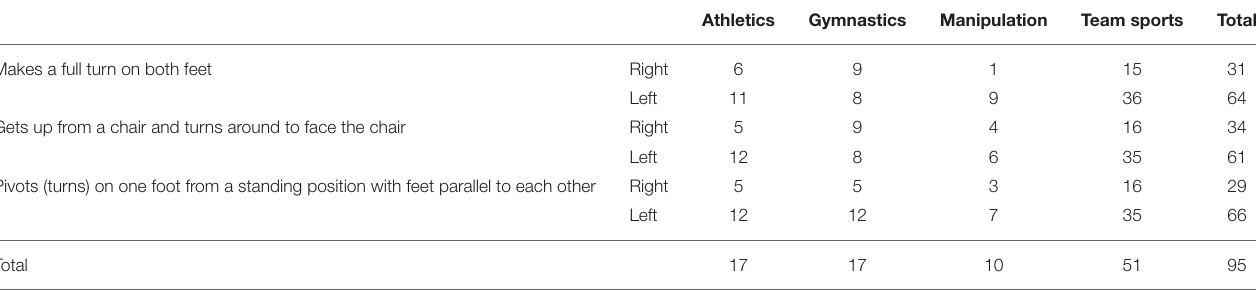
TABLE 9 | Frequencies involving turn direction skills by sport.